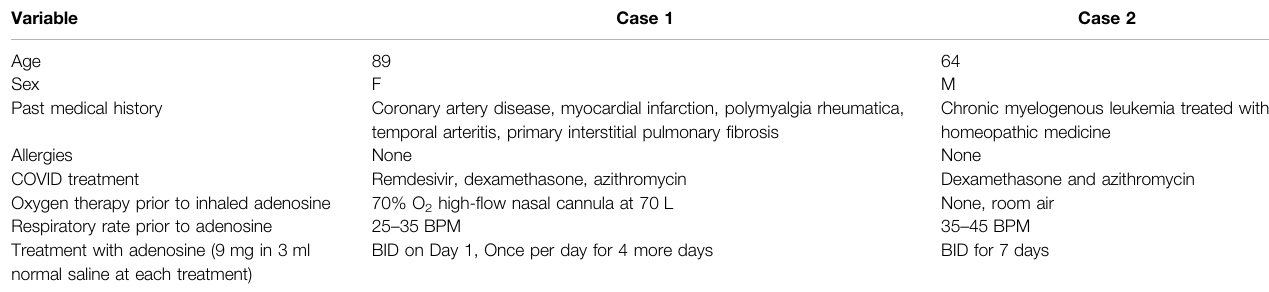
TABLE 1 | Characteristics of two patients treated with inhaled adenosine. Both were elderly/older and both had pre-existing medical